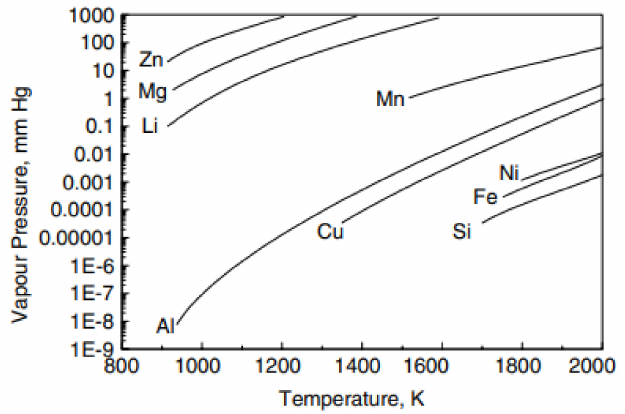
Figure 7. The relationship between equilibrium vapor pressure and temperature for elements